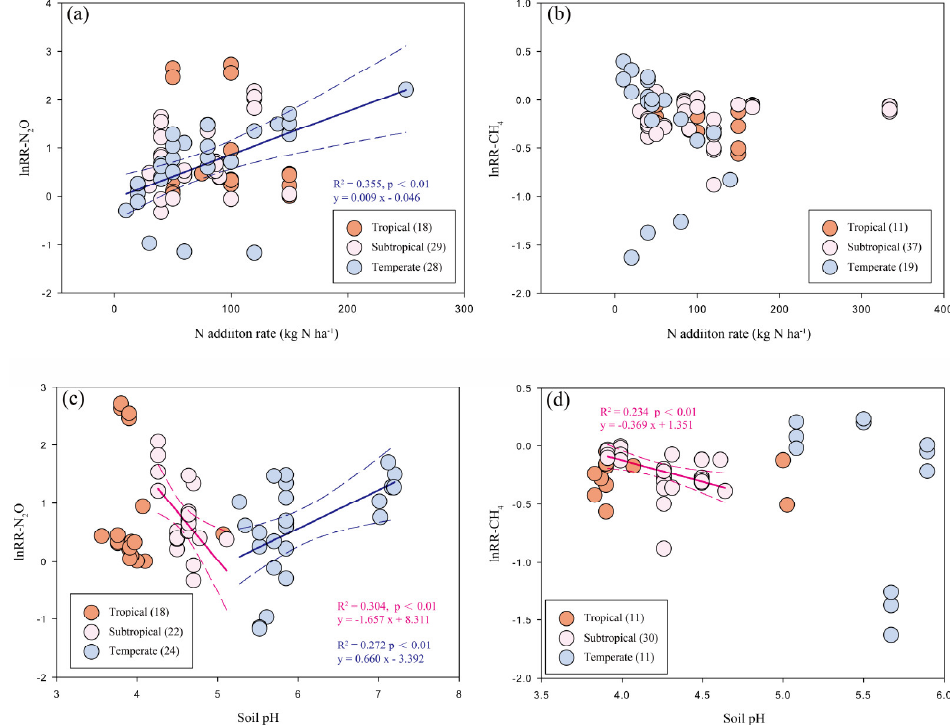
Figure 3. Relationship of N addition rates ( a , b ) or soil pH ( c , d ) with the response ratios of N 2 O and CH 4 fluxes to N inputs among different climatic zones in Chinese forests. Significance levels are set to p < 0.01. The solid lines represent the significant regression lines of different climatic zones.